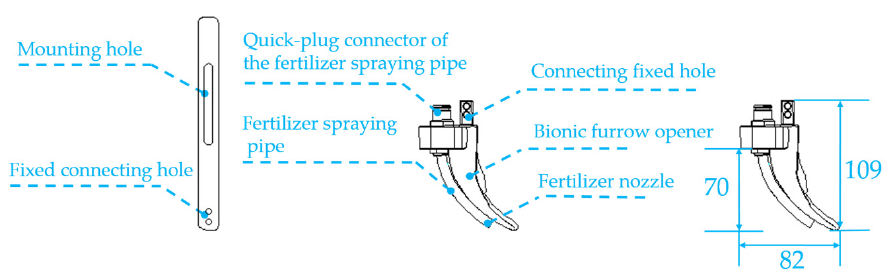
Figure 2. Structure diagram of the bionic liquid fertilizer deep application furrow opener.